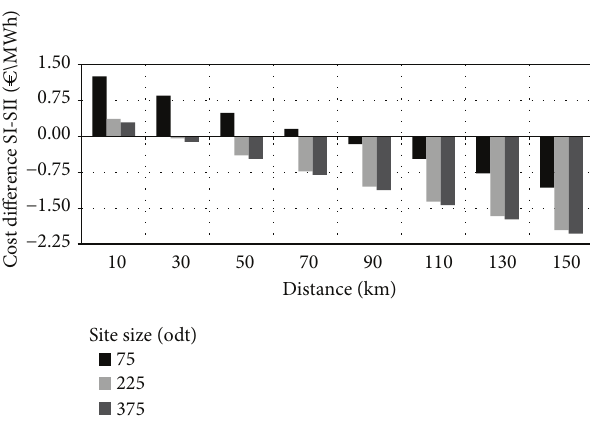
Figure 9: Cost difference between systems (I) and (II) for different values of stump harvesting site size (75–375 odt) and stump trans- port distance (10–150 km). A zero value indicates equally large